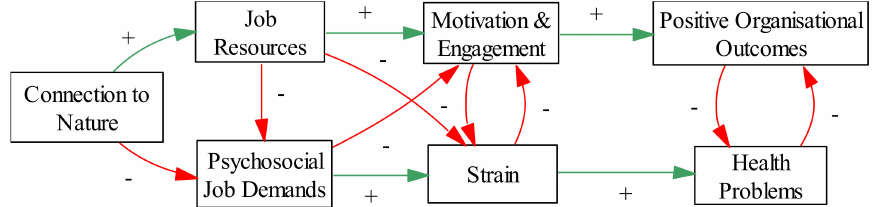
Figure 6. A causal diagram relating connection to natural and wellbeing outcomes. Note: green arrows indicate positive causal relations, and red arrows indicate negative causal